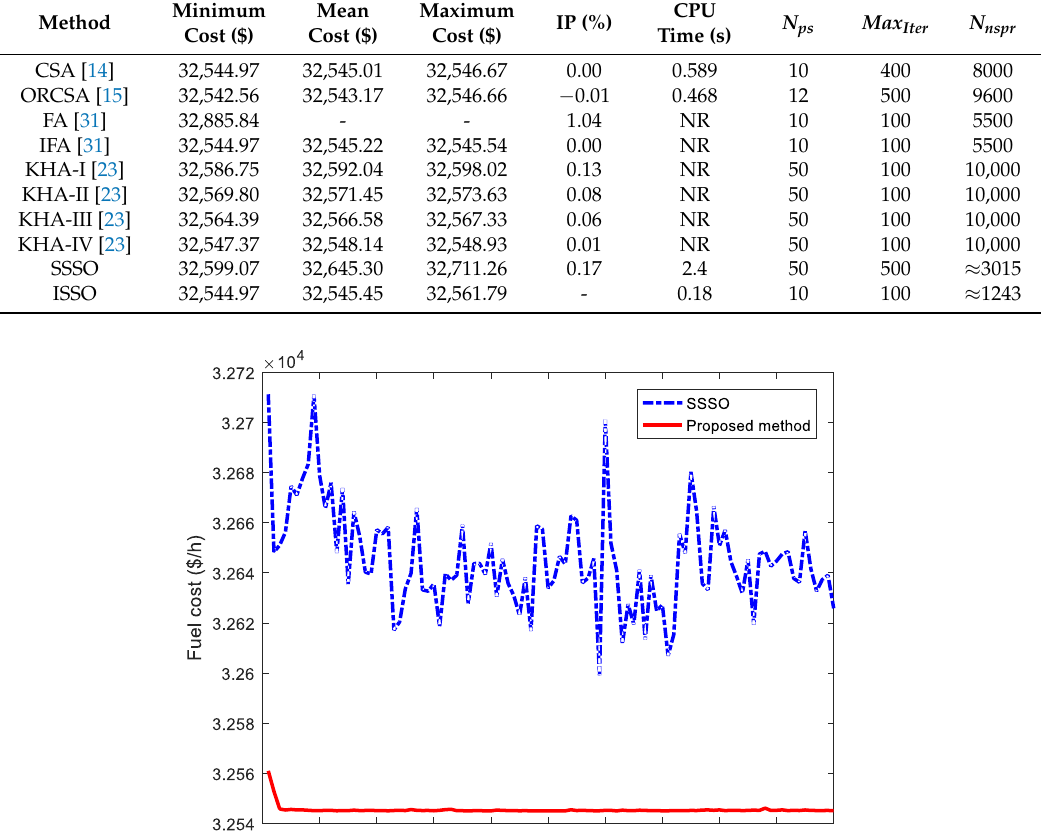
Table 6. Result summary obtained by different methods and the proposed method for system 3.